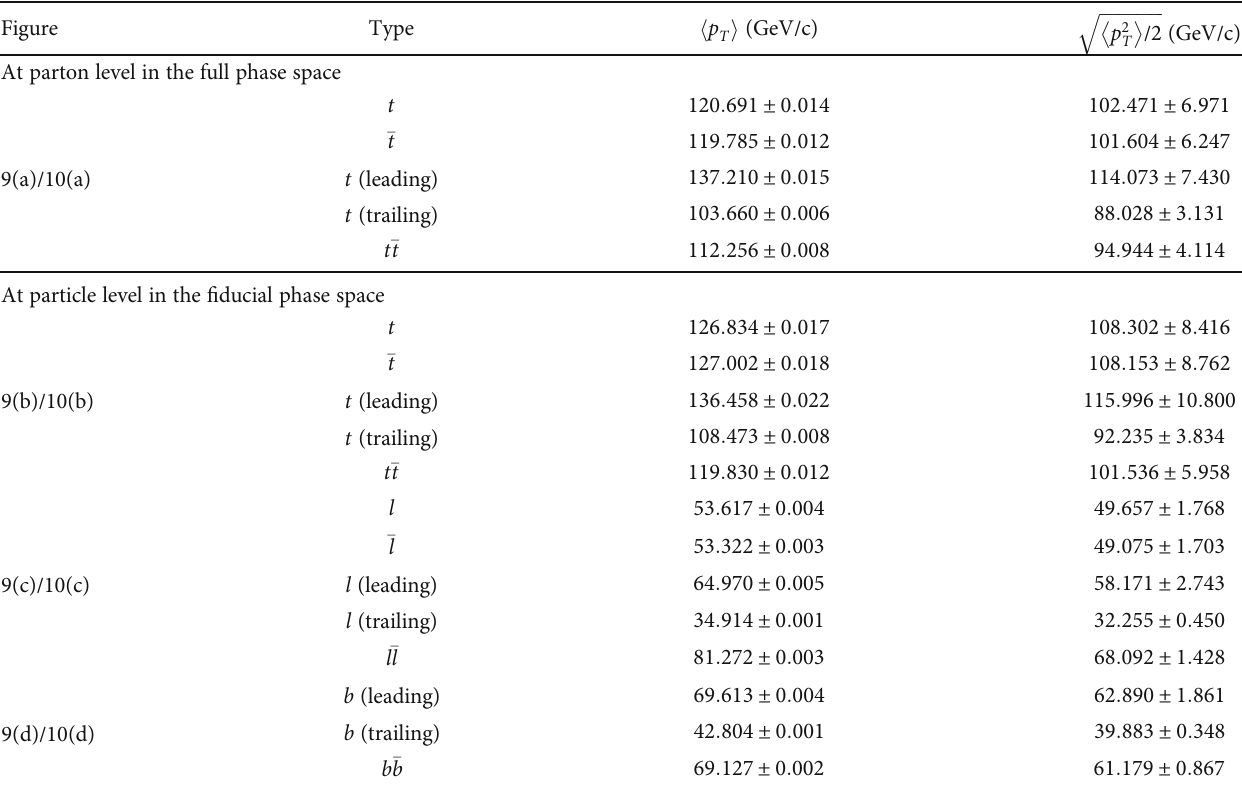
ffiffiffiffiffiffiffiffiffiffiffiffiffi p i and h p 2 i /2 are calculated by the curves in Figures 1, 3, 5, and 7. T T